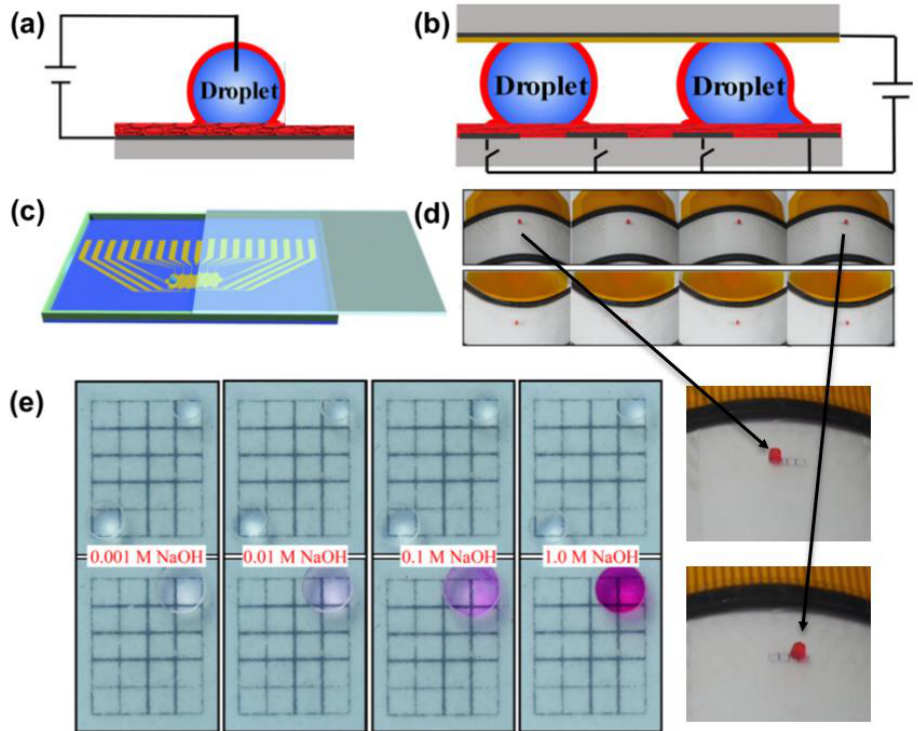
Figure 12. ( a ) Side-view image of a droplet on a slippery surface. The droplet was encapsulated by lubricant (red color). ( b ) Schematic of the electrowetting-on-dielectric (EWOD) microfluidic device. The insulative and conductive region is alternatively distributed. ( c ) The EWOD microfluidic device was with a droplet sandwiched by the top and bottom plates, driven by voltages applied to the patterned electrodes. ( d ) Demonstration of driving a 1.0 μL droplet to slowly move between 4 electrodes on convex and concave surfaces, respectively and corresponding enlarged views. ( e ) Side view image of a droplet on EWOD Images of actuating 1.0 μL NaOH aqueous droplet (0.001, 0.01, 0.1, and 1.0 M, respectively) at the bottom left corner to move and mix with a 1.0 μL phenolphthalein droplet (0.5 wt %). Reprinted with permission from [48]. Copyright (2019) Elsevier B.V.